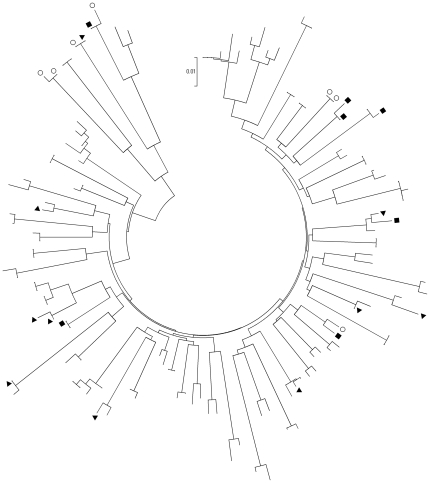
Evolutionary relationships of the 125 HIV-1 reverse transcriptase genes involved into cluster transmissions.The evolutionary history was inferred using the neighbour-joining method [35]. The optimal tree with the sum of branch length = 1.69802916 is shown. The tree is drawn to scale, with branch length in the same units as those of the evolutionary distances used to infer the phylogenetic tree. The evolutionary distances were computed using the Maximum Composite Likelihood method [37] and are in the units of the number of base substitutions per site. Codon positions included were 1st+2nd+3rd+noncoding. All positions containing gaps and missing data were eliminated from the dataset. There were a total of 408 positions in the final dataset. Phylogenetic analyses were conducted in MEGA4 [38]. Viruses isolated in women (○), male infected through heterosexual intercourse (▪) and patients (all were men) infected through unknown intercourse (▾) were represented.